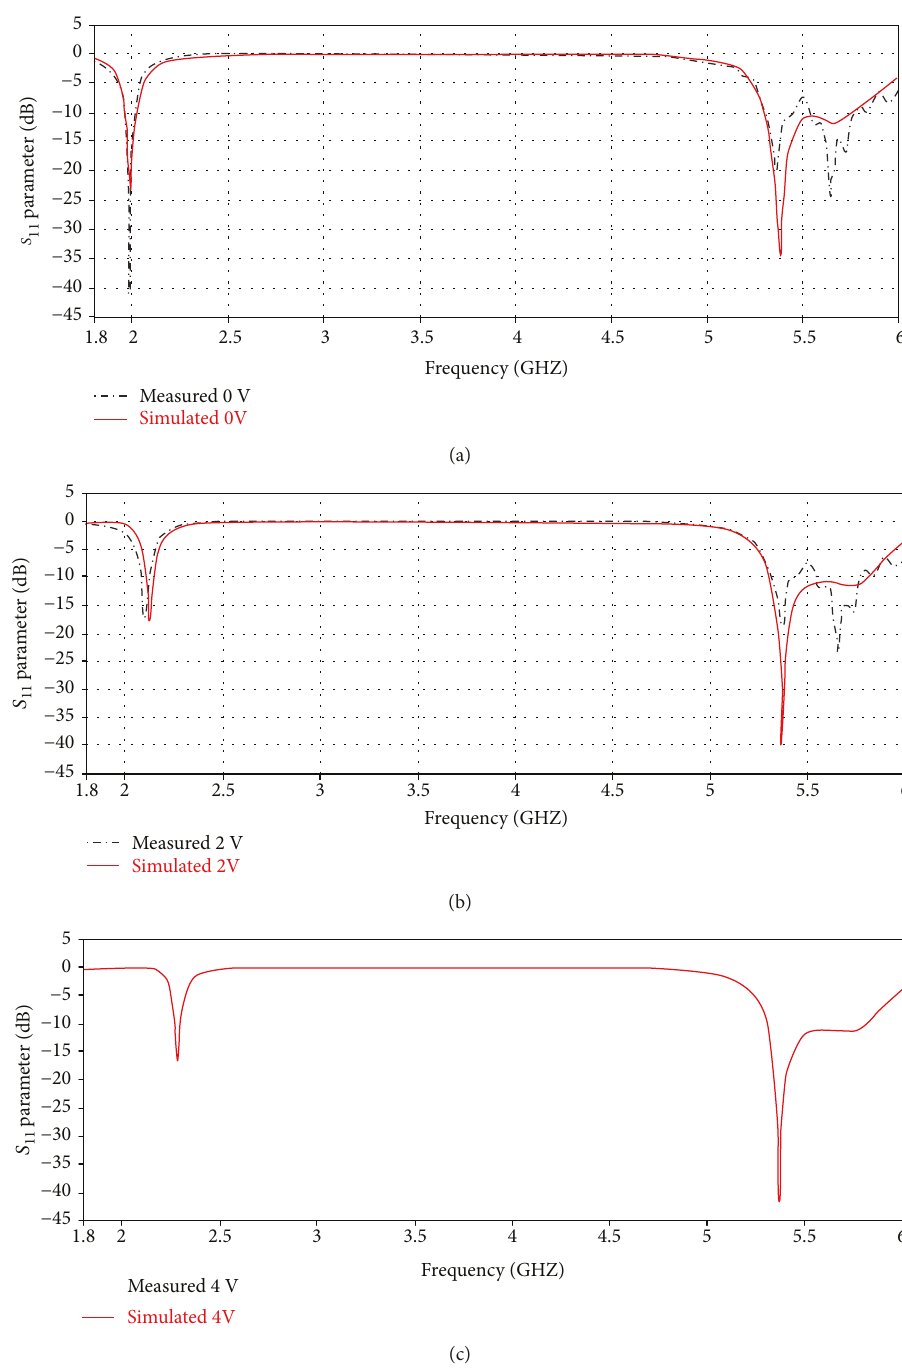
ff erent biasing voltages: (a) 0V, (b) 2V, and (c) 4 11 parameter for di